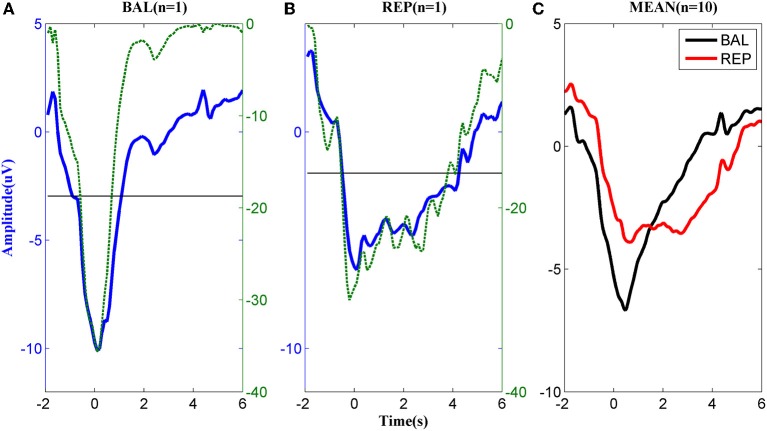
MRCP corresponding to (A) ballistic (BAL) and (B) repetitive (REP) motor imagery from a typical subject. The dashed lines indicate the logarithmic p-value of the paired t-test between the MRCP (either ballistic or repetitive) and its reference between −3 and −2 s., while the solid horizontal line indicates significance level. (C): The average MRCP over the 10 subjects. The black line corresponds to ballistic imagery and the red line to the repetitive motor imagery.